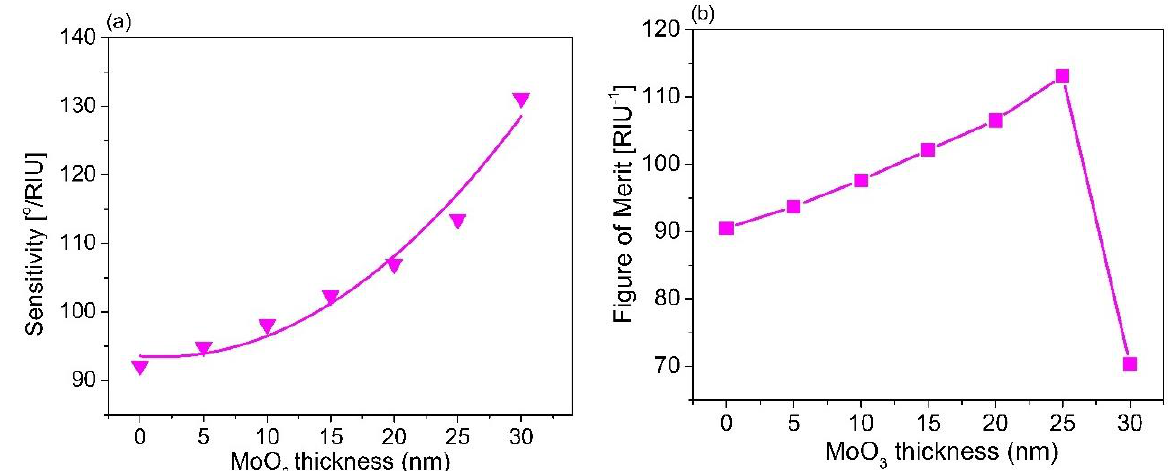
Figure 10. ( a ) The dependence of sensor sensitivity versus the thickness of the MoO 3 layer; ( b ) The comparison of the FOM of the sensor performance for various MoO 3 thicknesses. Table 4. Kinetic parameters for sensor sensitivity performance with three different materials of outermost layer (AlAs, ZnO, and MoO 3 ).